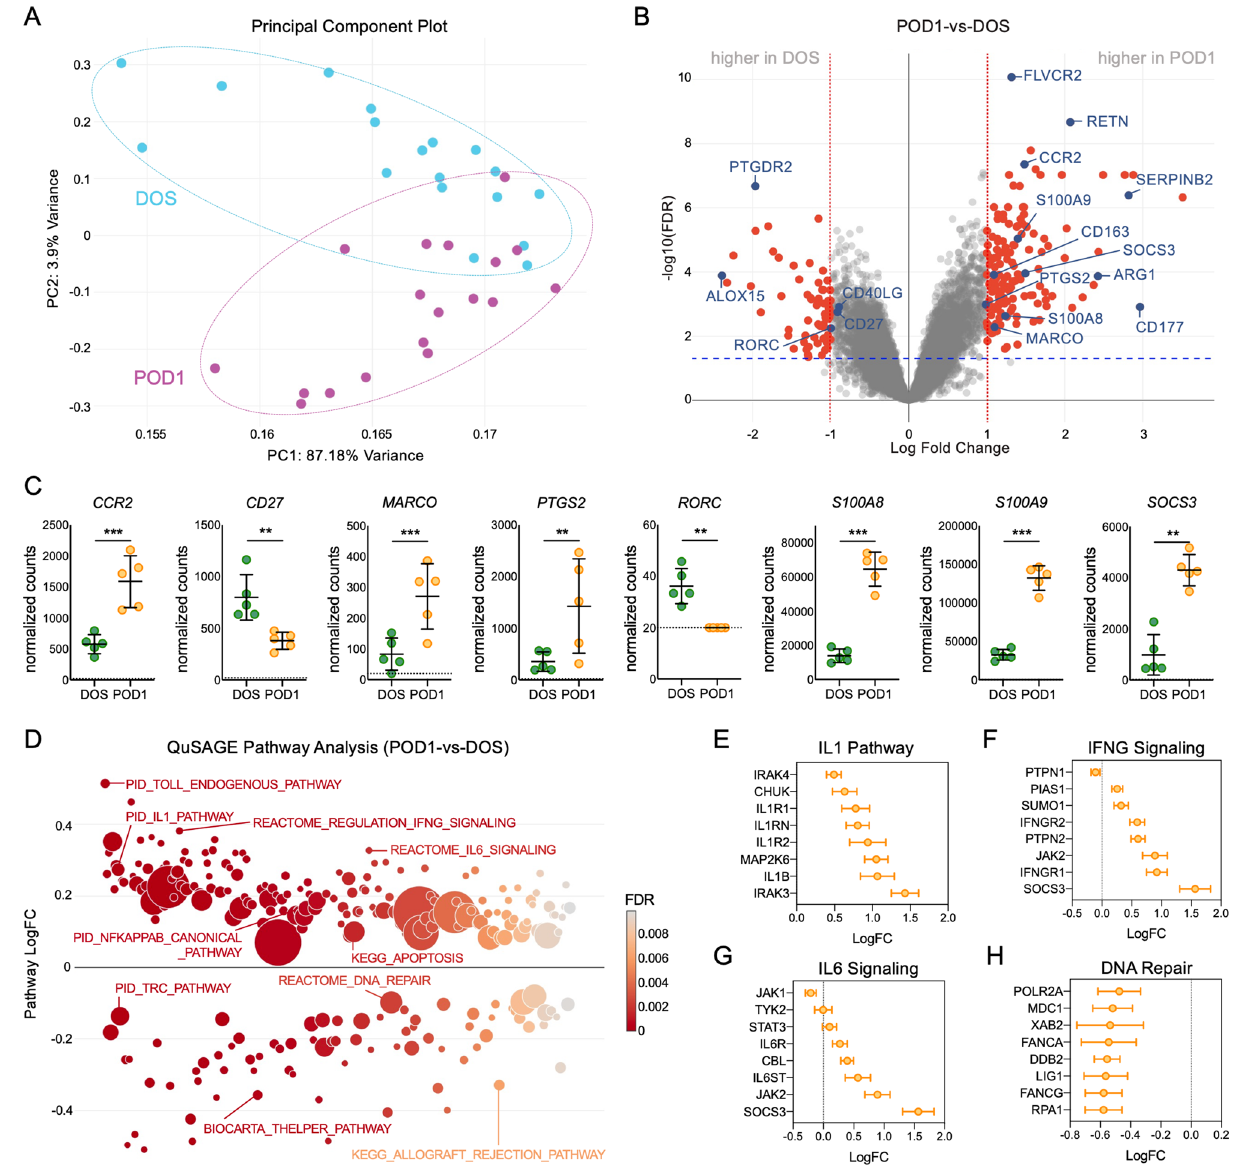
Figure 3. RNA-seq analyses of the responses to total knee arthroplasty in total RNA isolated from PAXgene blood RNA tubes. ( A ) Principal component analysis (PCA, using top 1,000 genes) of RNA-seq data from POD1 (24 h after surgery) and DOS (day of surgery). RNA-seq analysis is based on 36 samples obtained from 18 patients at DOS and POD1. ( B ) Volcano plot representing the differentially expressed genes comparing POD1 to DOS samples. Red dots correspond to genes with significant changes greater than 1 log2-fold expression change (FDR < 0.05, LogFC > 1). Selected genes with increased or decreased expression that were also identified by NanoString analyses are highlighted in blue. ( C ) NanoString normalized counts of selected DEGs, confirming changes identified by RNA-seq. Dotted lines indicate background signal. ** p < 0.01, *** p < 0.001, by t -test, calculated using ratio data and the nSolver analysis software. NanoString data are represented as means ± S.D. (error bars) normalized counts. ( D ) Representation of the QuSAGE pathway analyses in POD1 relative to DOS, showing functional pathways differentially expressed at POD1 (FDR < 0.01). Representative genes associated with the ( E ) IL1, ( F ) IFNG signaling, ( G ) IL6 signaling, and ( H ) DNA repair pathways are shown, representing changes in gene expression (logFC) in POD1 vs. DOS samples. Graphs were created with GraphPad Prism 8 (GraphPad Software, San Diego,